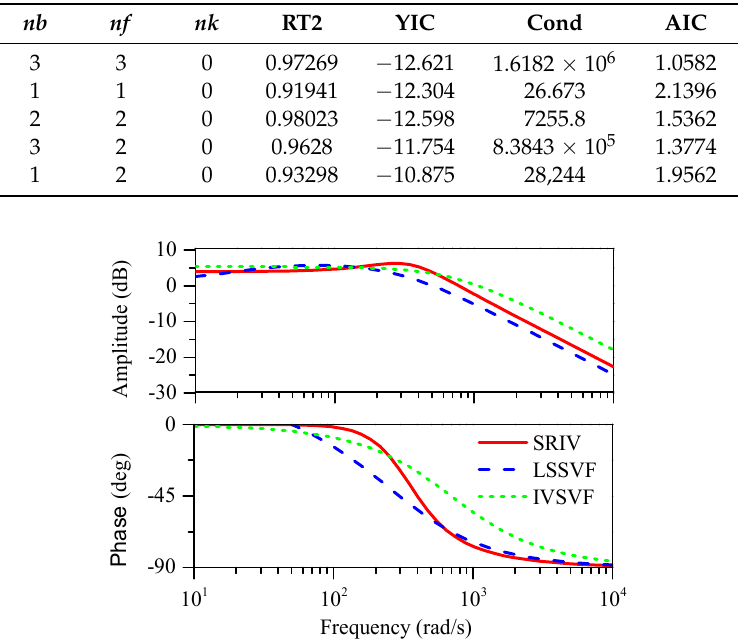
Table 6. Evaluation of the identification results using different model structures.